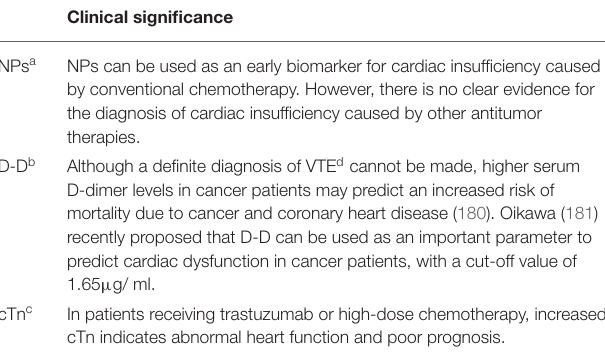
TABLE 3 | The significance of monitoring biomarkers in cancer